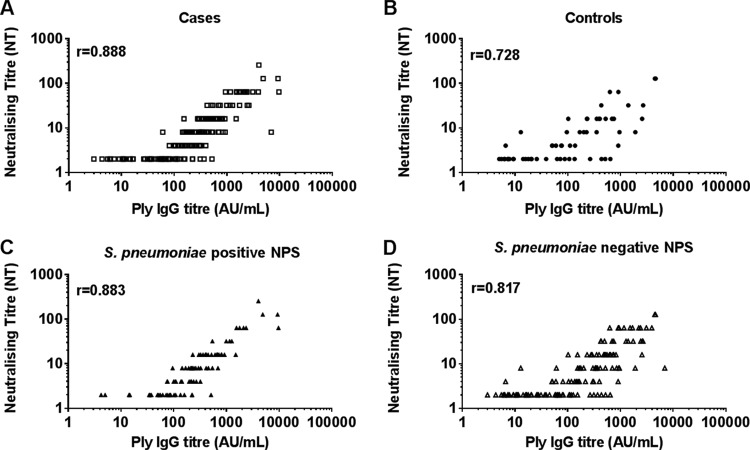
Correlation between pneumolysin (Ply) IgG titers (AU per milliliter) and neutralizing titers (NTs) for sera from otitis-prone (A) and healthy (B) children and children colonized (C) and not colonized (D) with S. pneumoniae. In all groups, there was a strong and significant correlation between Ply IgG titers and NTs (P < 0.0001). NPS, nasopharyngeal swab.